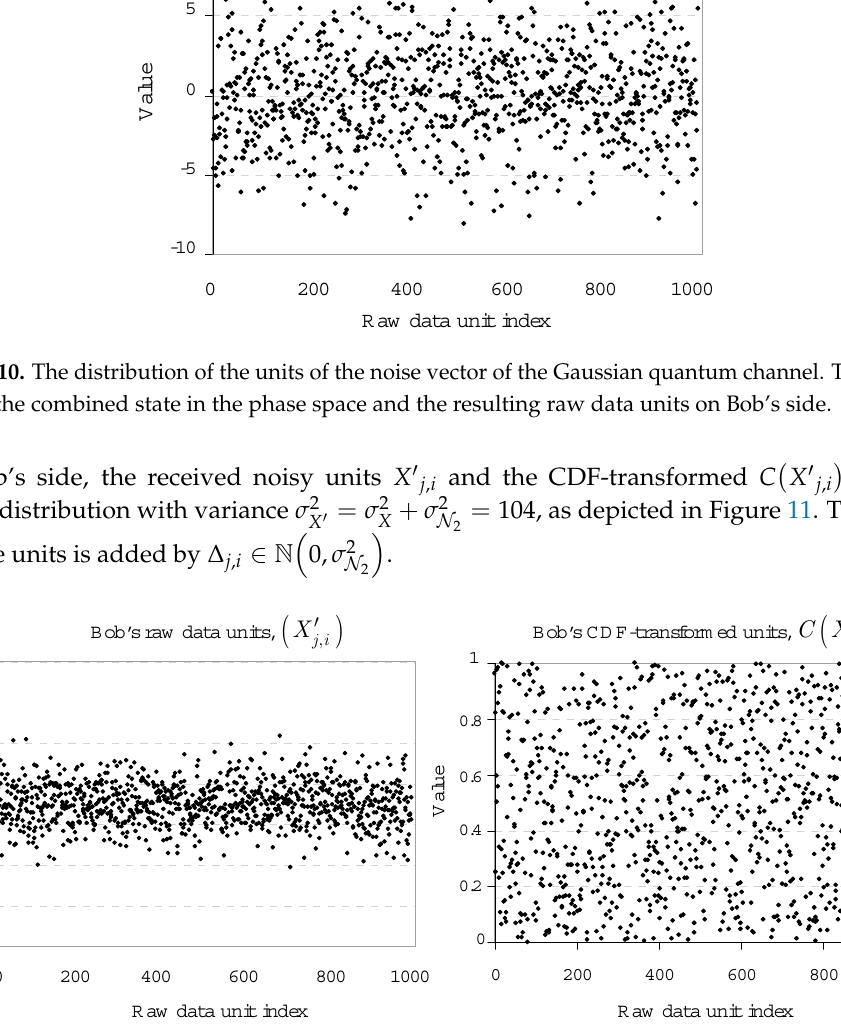
Figure 11. ( a ) The distribution of the noisy raw data units on Bob’s side; ( b ) The CDF-transformed raw data units have uniform distribution in [ 0,1 ]